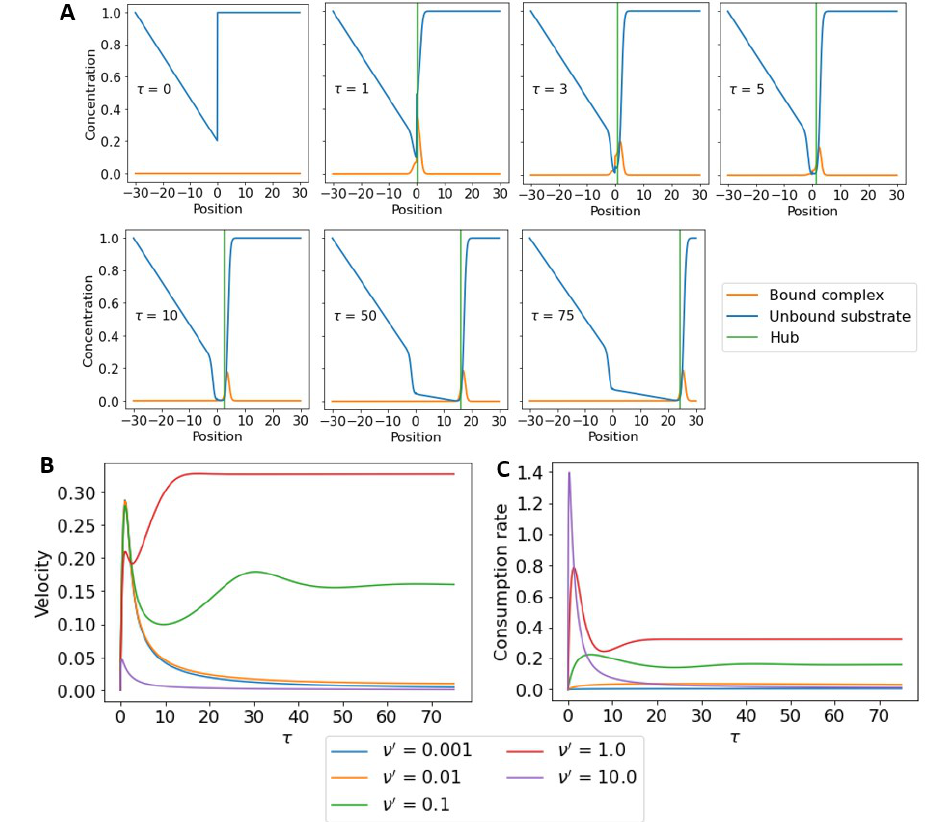
Figure 2. Time dependence of hub velocity and substrate consumption rate. ( A ) Substrate concentration profiles and the hub position at different points in time. ( B ) The velocity of the motor as a function of time at different burn rates, ν (cid:48) . There is an initial transient period where the hub accelerates and attains peak speed. For some burn rates, the hub eventually achieves a constant steady-state velocity. Whereas at very high or very low burn rates, there is a steady slowing down of the hub with time. ( C ) The consumption rate, b , as a function of time at different burn rates. The substrate consumption rate peaks and reaches steady state at similar times to the velocity. In all of the above calculations, = K = a tot = 1, ω (cid:48) = 0, k (cid:48) of f